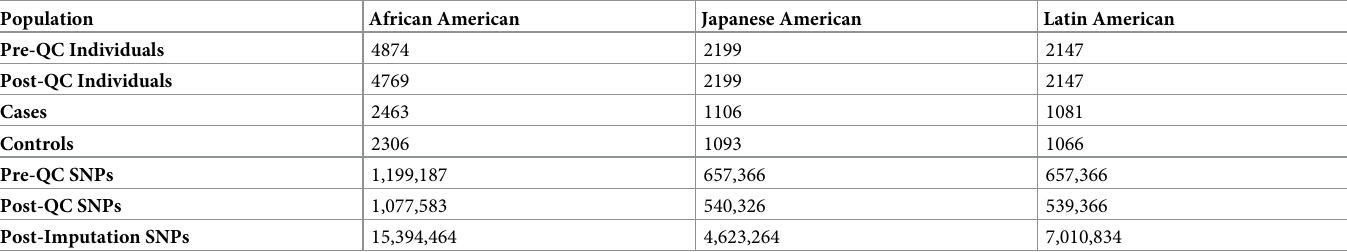
Table 1. Population characteristics: Genotype and phenotype data from the three populations went through standard genome-wide quality control and genotype imputation.